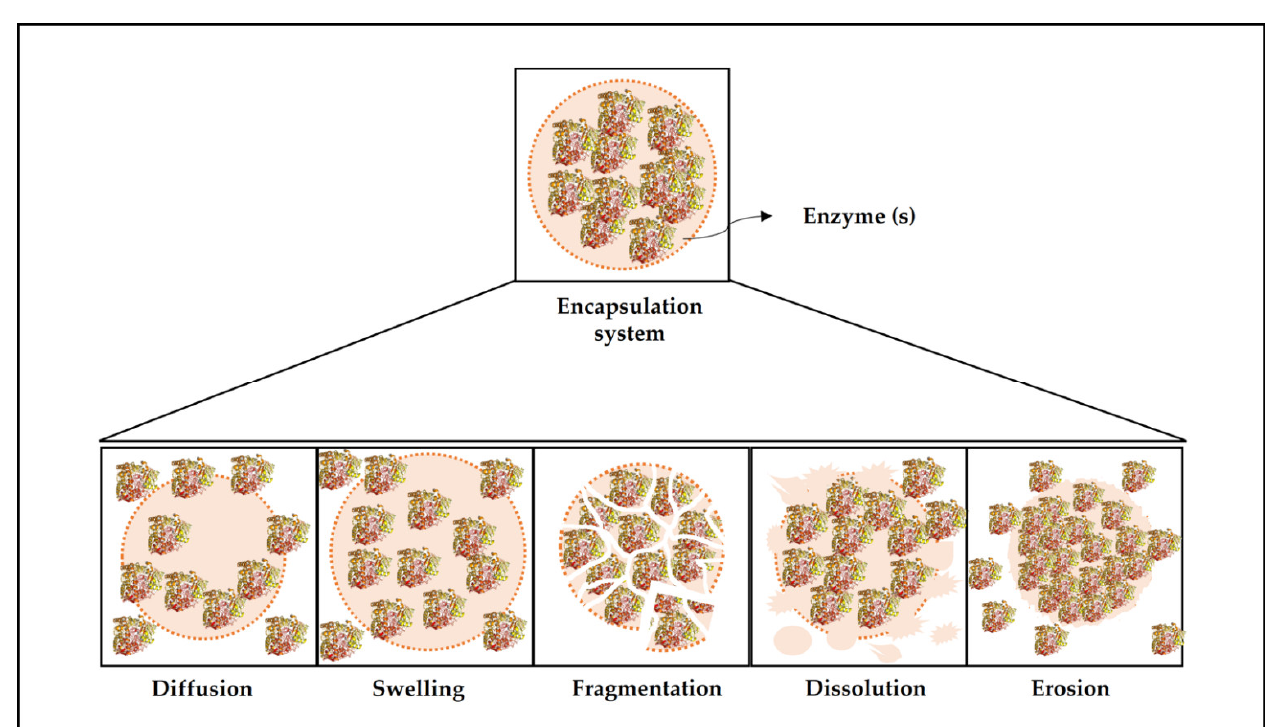
Figure 4. Different mechanisms of enzyme release from polymeric matrices.